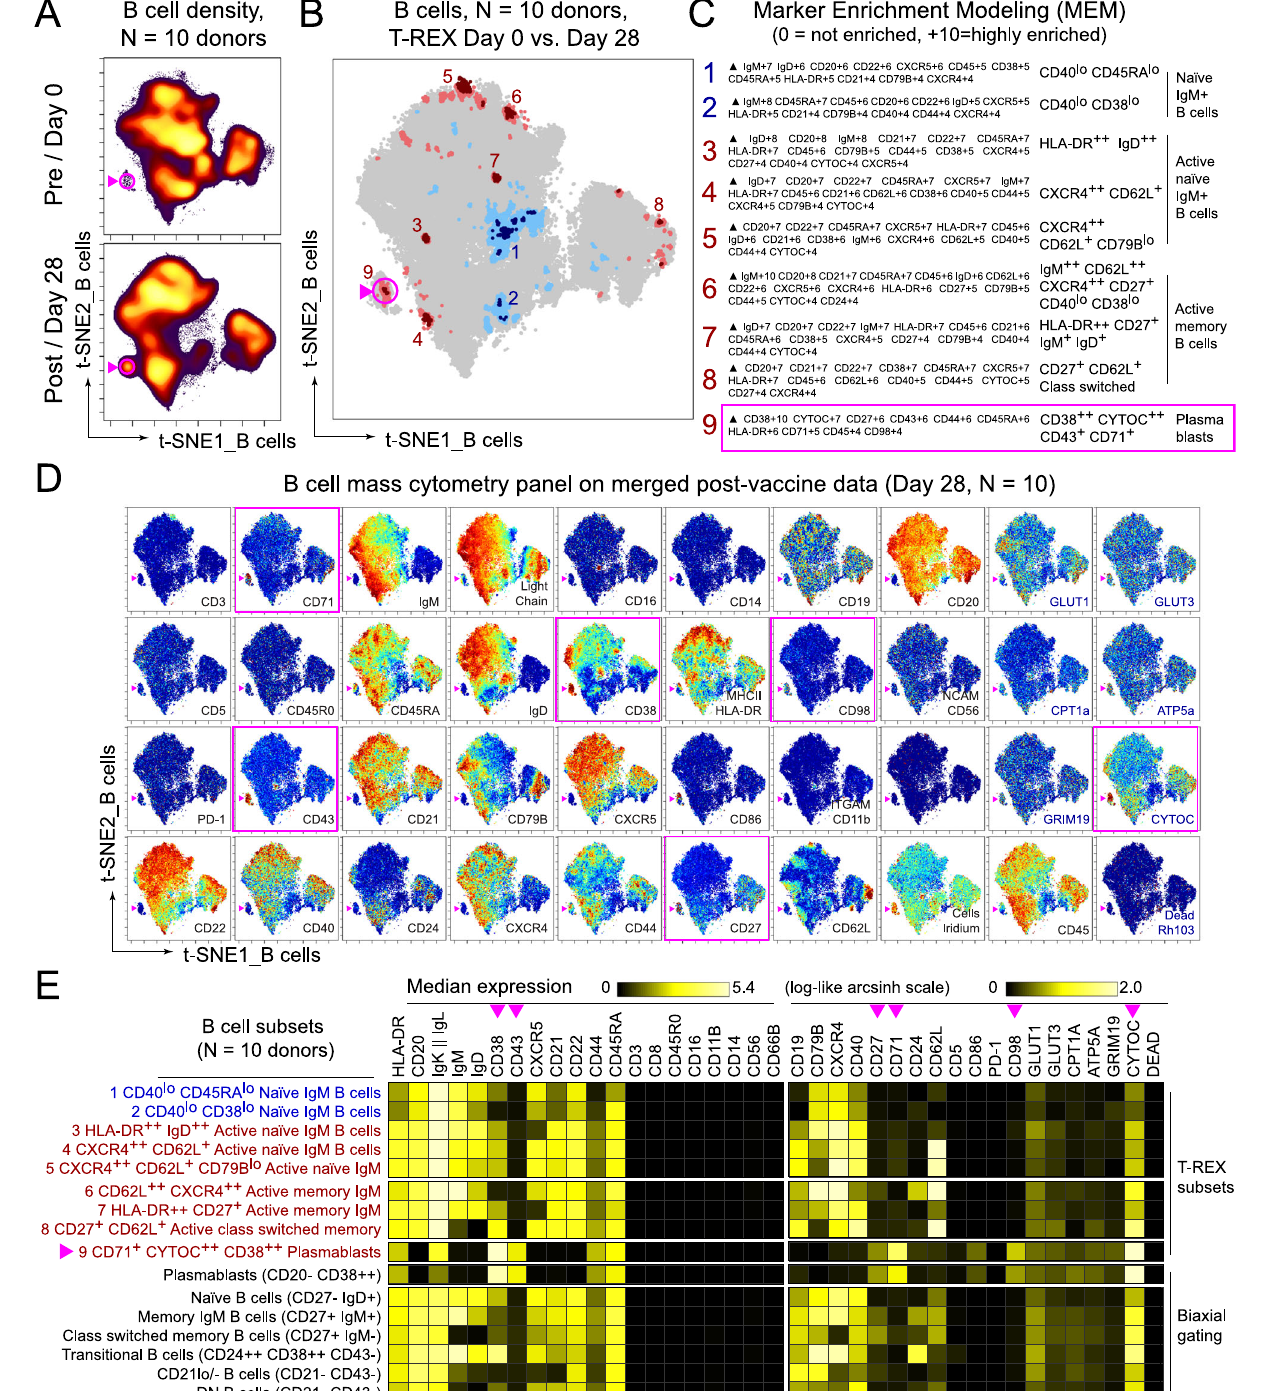
transcriptionally de fi ne B-cell subset identities of SARS-CoV-2- binding B cells over time following vaccination. Nine clusters were identi fi ed by UMAP across all B cells based on gene expression pro fi les that represented naive, predominantly IgM memory (termed “ memory ” ), predominantly IgA or IgG- switched memory (termed “ switched memory ” ), or plasmablast populations (Fig. 7A, B, Supplementary Fig. 8A, B). Characteristic gene expression patterns de fi ned each B-cell subset (Fig. 7C, Supplementary Fig. 8C). The analysis focused speci fi cally on B